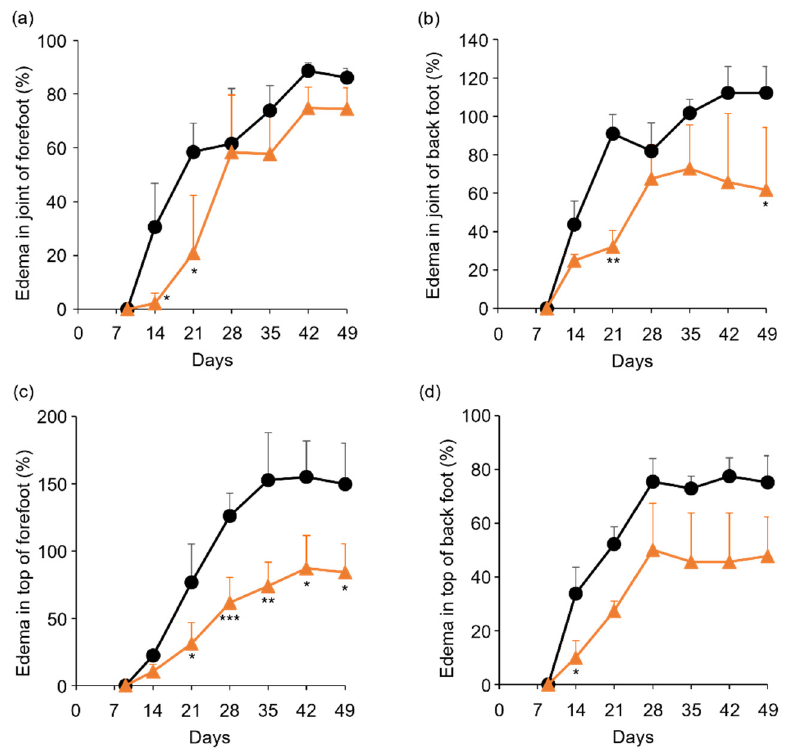
Figure 5. Comparison of edema ratio (%) between control and TP-administered mice. ( a – d ) PBS ( − ) (black lines) and TP dissolved in PBS ( − ) (orange lines) were intraperitoneally administered into mice three times a week from 7 days after laminarin injection. Edema ratios were calculated as described in materials and methods section. ( a , b ) Joint of forefoot ( a ) and back foot ( b ). ( c , d ) Top of forefoot ( c ) and back foot ( d ). N = 3, Bars represent SD. * p < 0.05, ** p < 0.01 and *** p < 0.001.